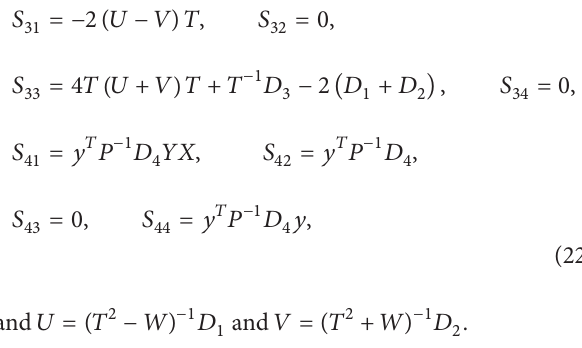
Algorithm 2. The interior pointer algorithm (IPA) is as